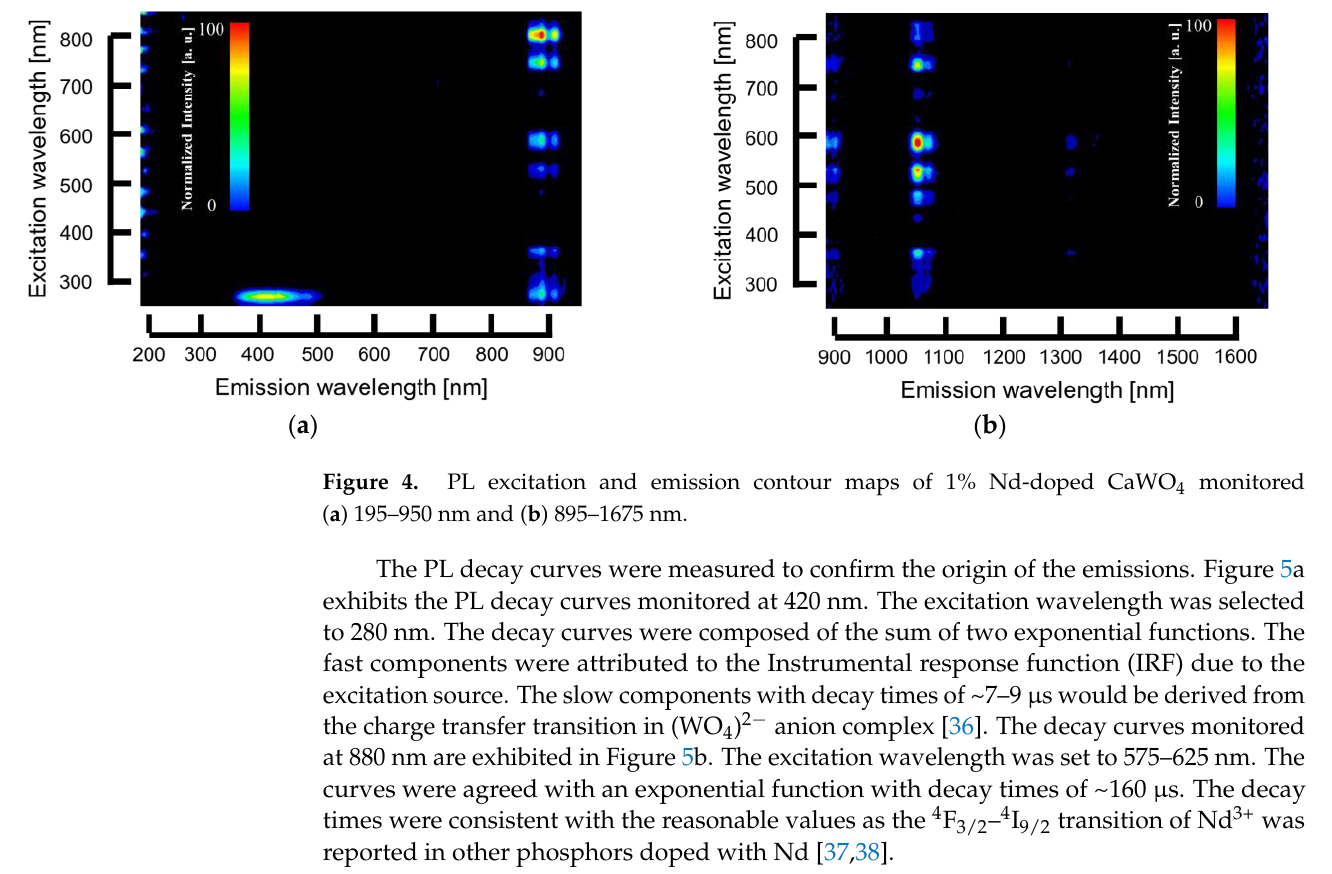
Figure 3. Diffuse transmission spectra of Nd-doped CaWO 4 . The excitation and emission contour maps of the 1% Nd-doped CaWO 4 crystal are exhibited in Figure 4a,b as a representative. No significant change was observed in the spectral shapes of the other two crystals. The vertical axis presents the excitation wave- length, and the horizontal axis presents the emission wavelength. A broad emission band was confirmed at 350 – 500 nm under excitation wavelength at 250 – 300 nm. It would be derived from the host (CaWO 4 ) [35]. In the NIR range, some emissions were confirmed at 900, 1060, and 1300 nm, and they were ascribed to the typical emissions derived from the 4f – 4f transitions of Nd 3+ [34,35]. The quantum yields ( QY ) of the crystals accumulated 750 – 1500 nm under excitation at 590 nm of 0.1, 0.5, and 1% doped samples were 70.7, 79.5, and 61.2%, respectively.